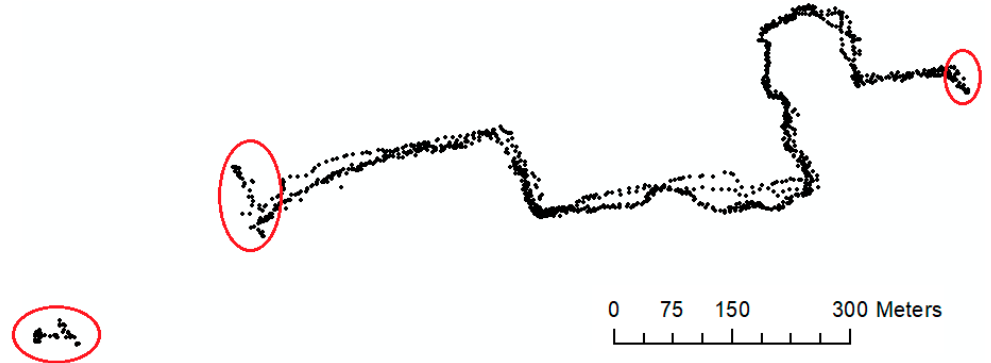
Figure 5. Raw GPS data before preprocessing—1559 points, and 287 GPS points counted as noise (in red circles).